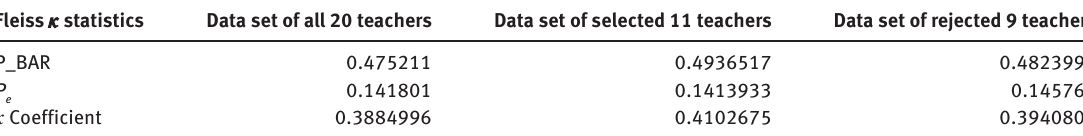
Table 10: Summary of Fleiss κ Statistics for Agreement between All 20 Experts vs. Selected 11 Experts vs. Rejected Nine